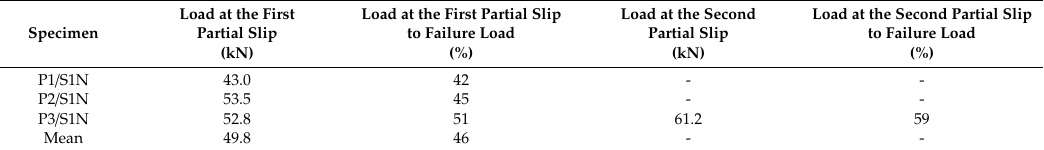
Table 5. Summary of the loads resulting in the partial slip of the specimens tested in S2N series.